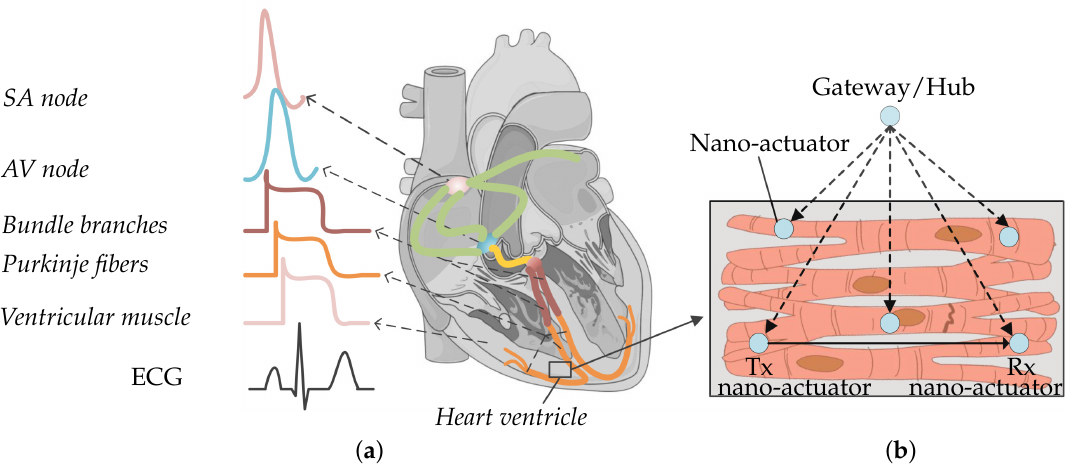
Figure 1. ( a ) Nodes from different parts of the heart produce diverse action potential signals. The composition of action potentials generates an ECG signal. ( b ) Nano-actuator pacemaker network in the heart ventricle: multiple nano-actuators are distributed in the ventricle and are coordinated by the gateway/hub. The nano-actuators are envisioned to share information to enhance their abilities [1]. The figure is adapted from an existing image provided by Servier Medical Art by Servier, licensed